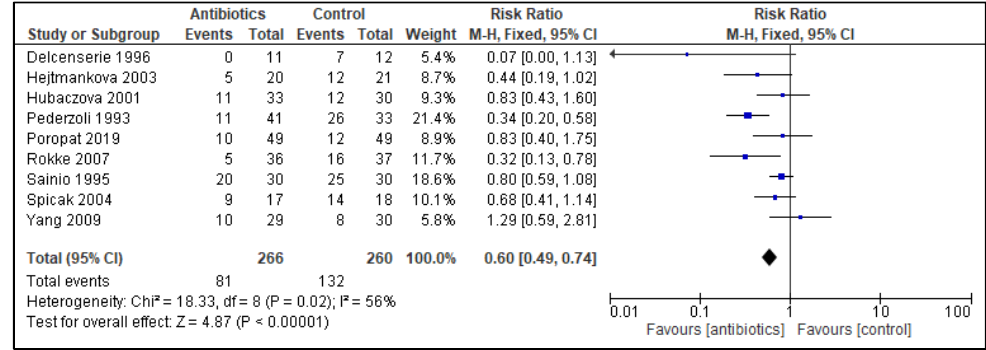
Figure 2. Forest plot of comparison of antibiotics versus control; outcome: all infectious complica- tions. Infections were registered in 81 out of 266 patients receiving PAB versus a 132 out of 260 control patients, which resulted in a RR 0.60 (95% CI 0.49 to 0.74) favoring antibiotic usage, with a heterogeneity of 56%.